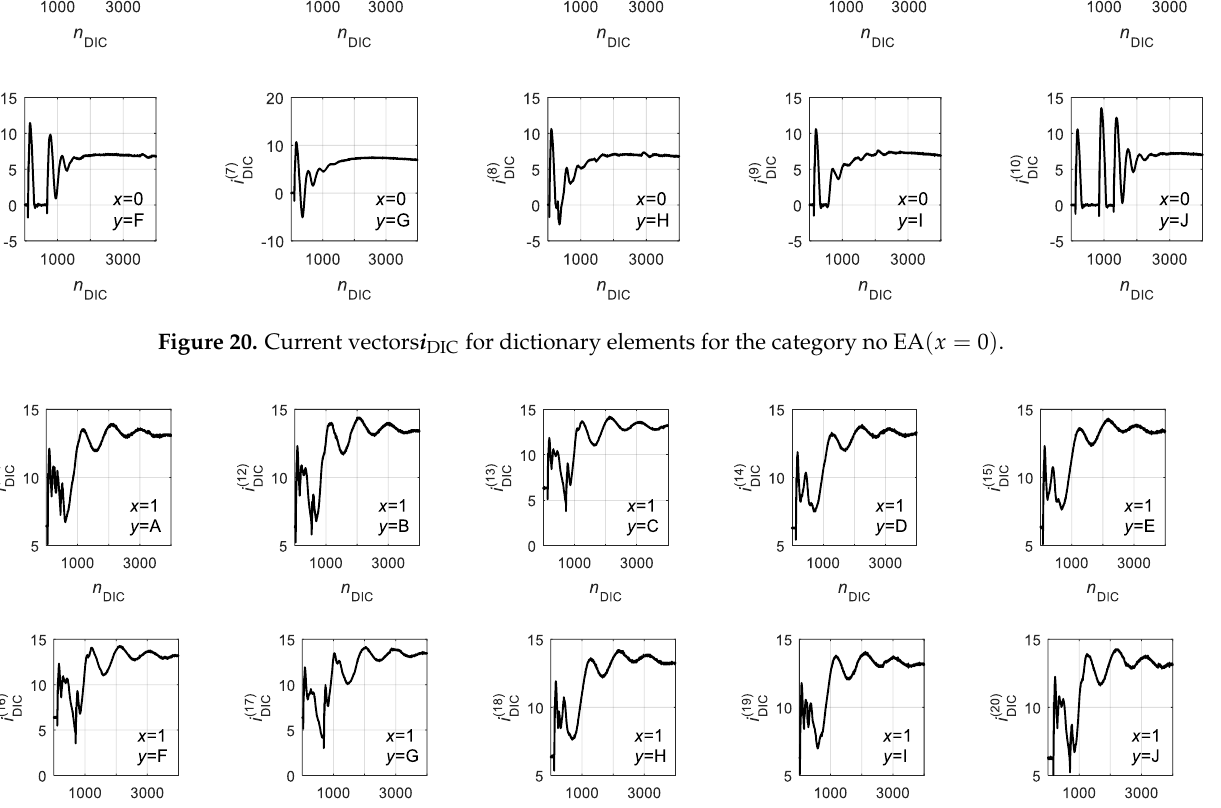
Figure 21. Current vectors